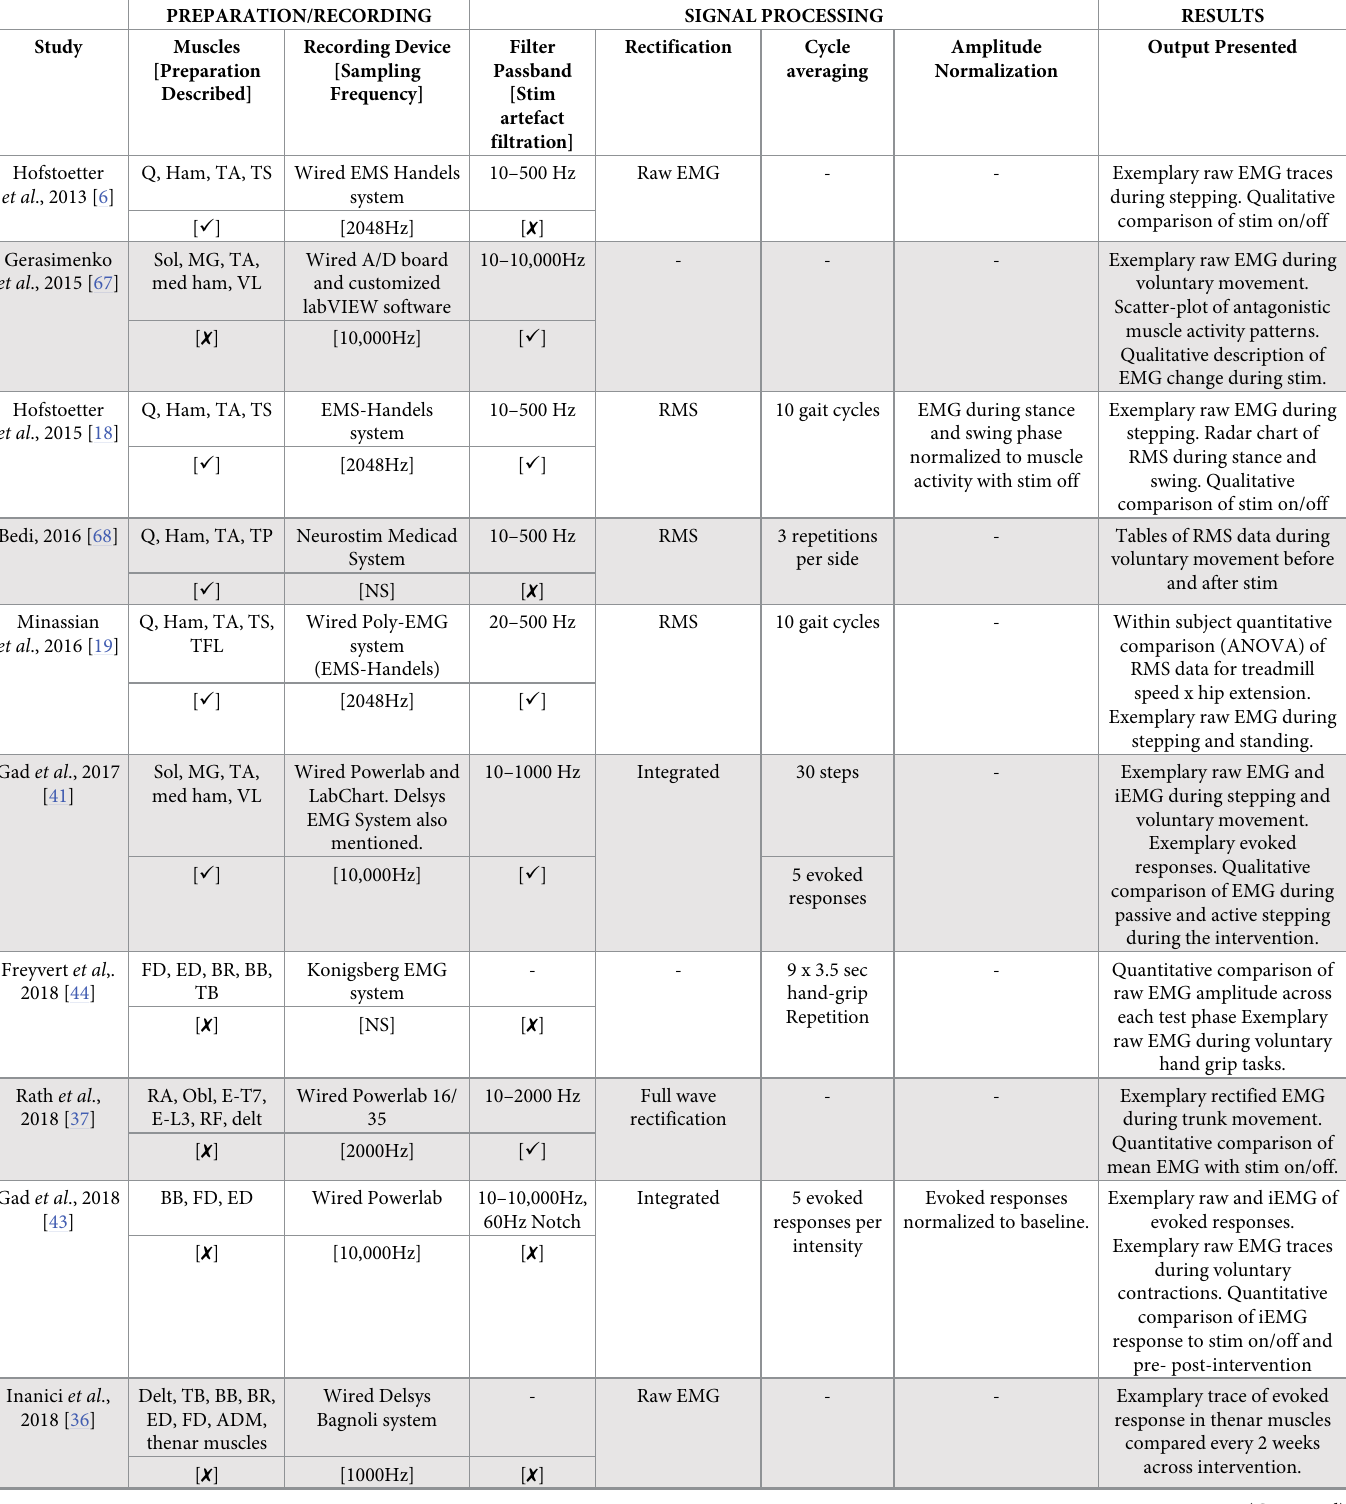
Table 10. A summary of dynamic surface EMG data collection, recording and signal processing. EMG recording and signal processing for therapeutic studies.